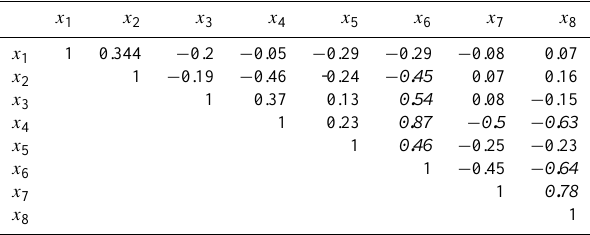
Table 3. Coefficients of correlations between variables. Table 4. Eigenvalues of components.